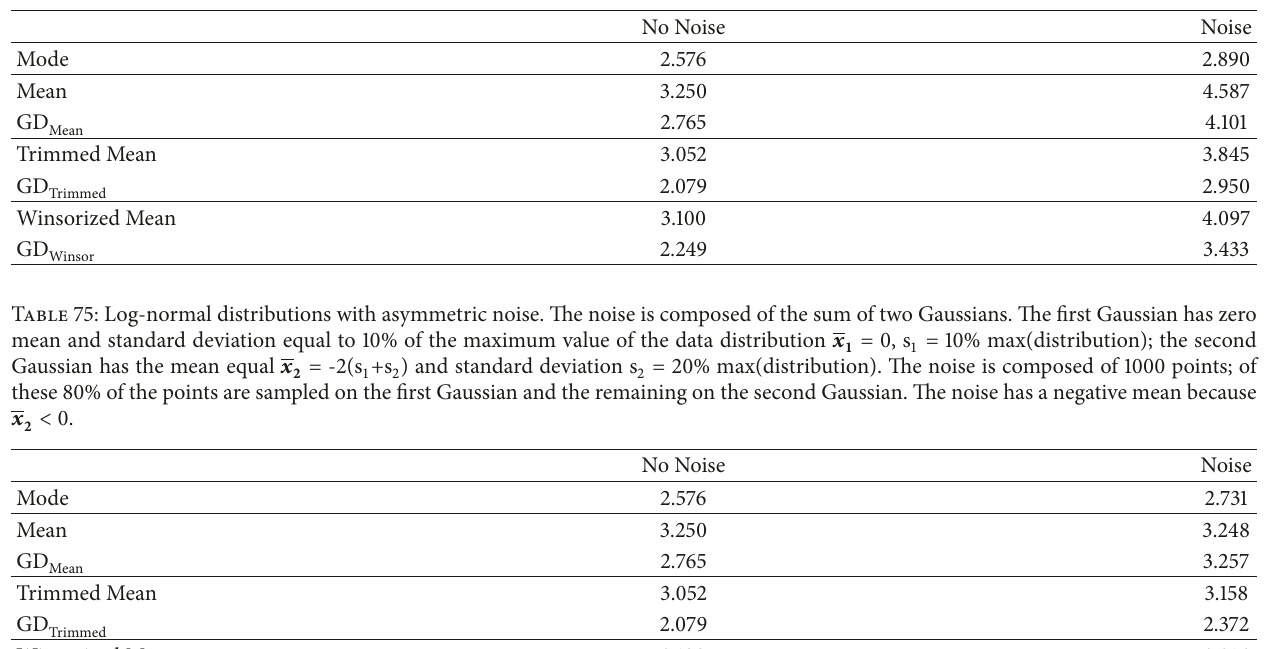
Table 74: Log-normal distributions with asymmetric noise. The noise is composed of the sum of two Gaussians. The first Gaussian has zero mean and standard deviation equal to 10% of the maximum value of the data distribution 𝑥 1 = 0, s 1 = 10% max(distribution); the second Gaussian has the mean equal 𝑥 2 = 2( s 1 + s 2 ) and standard deviation s 2 = 20% max(distribution). The noise is composed of 1000 points; of these 80% of the points are sampled on the first Gaussian and the remaining on the second Gaussian. The noise has a positive mean because 𝑥 2 > 0.